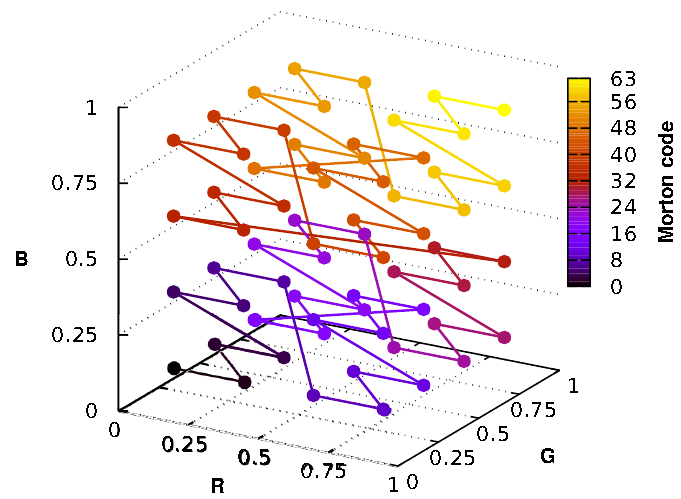
Figure 3. Z-curve subdividing the normalised RGB colour space for nominal colour generation. Each 3-dimensional RGB coordinate maps to a unique linearised index, the Morton code , corresponding to the cumulative length of the curve starting at the origin (bottom left) and ending at unity (upper